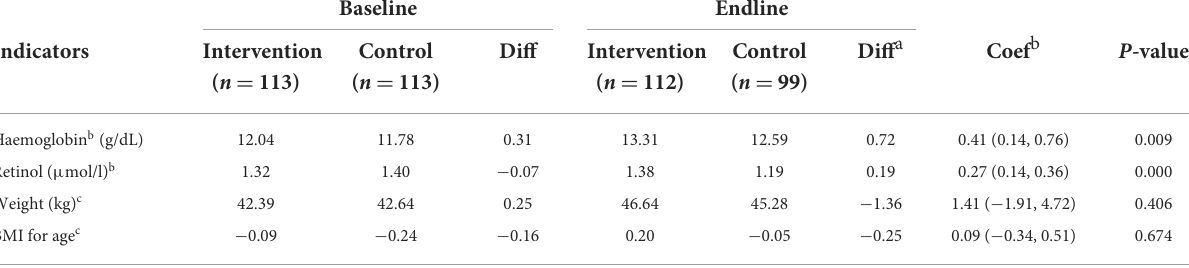
TABLE 2 Changes in biomarkers between the intervention and control groups.